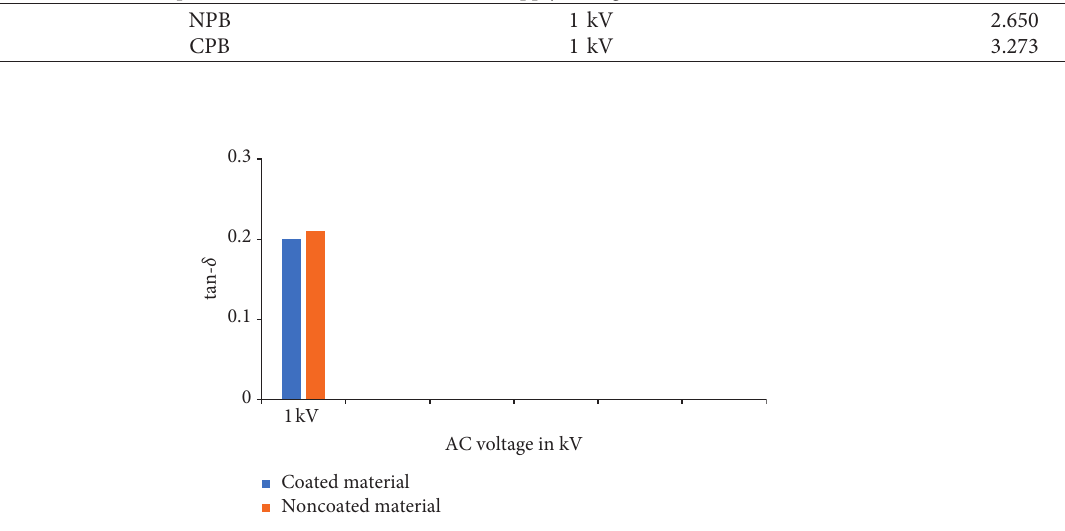
Figure 11: Dielectric constant of specimens (NPB and CPB) vs supply